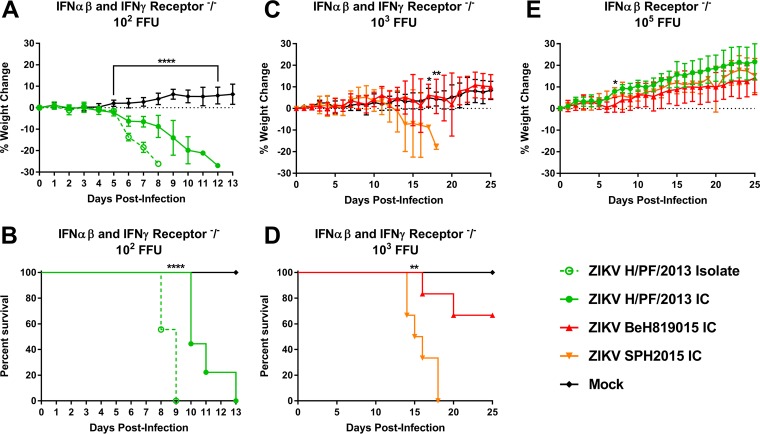
In vivo pathogenesis studies. ZIKV H/PF/2013 isolate (n = 9), infectious clone virus (n = 9), or PBS (n = 7) was inoculated into IFNGR-knockout mice by footpad inoculation with 102 FFU (A and B). In parallel, Ifnar1−/− and Ifngr1−/− mice were inoculated by footpad injection with 103 FFU of BeH819015 (n = 6) or SPH2015 (n = 6) infectious clone or PBS (n = 3) (C and D) or 105 FFU of recombinant SPH2015 (n = 5), BeH819015 (n = 5), or H/PF/2013 (n = 5) infectious clone (E), respectively. Weight loss and mortality were recorded through 25 days postinfection or until all animals had succumbed to infection.